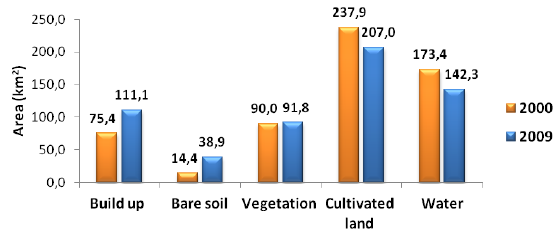
Table 8. 2000-2009 land use/cover changes matrix (km 2 )